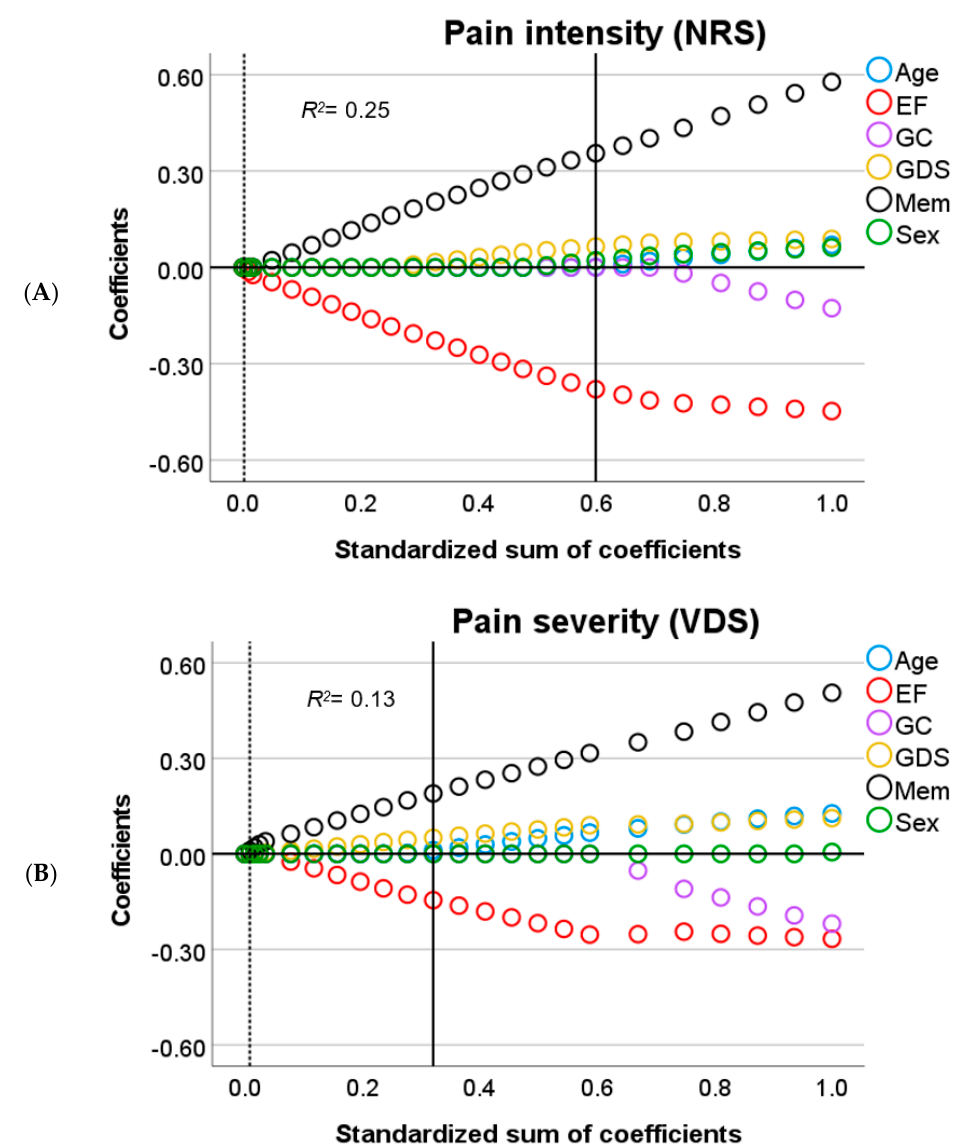
Figure 2. Output charts Lasso regression (Model 1) . Input predictors are displayed in alphabetical order but were introduced as follows: sex, age, Geriatric Depression Scale score (GDS), executive function (EF), global cognition (GC), and memory (Mem). Identified predictors and the respective dependent variables are: ( A ) sex, age, GDS, EF, and Mem as predictors of pain intensity by NRS; ( B ) age, GDS, EF, and Mem as predictors of pain severity by VDS. Lasso coefficients (colored rings) represent positively and negatively related predictors above and below zero, respectively (y–axis). Vertical lines intersect the coefficients ( ≠ 0) from the most parsimonious predictors (dotted line) and the optimal predictors (solid line) as computed in the different models (these lines might coincide). In each subfigure, the values of the x–axis represent the relative influence of all the parameters over the dependent variable before shrinkage (standardized sum of coefficients = 1.0 minus shrinkage = 0, which is equal to 1.0 on the right side). At each stage of shrinkage (increasing from right to left in the x–axis), a higher penalty is added until the standardized sum of coefficients is at its lowest (i.e., 0) and shrinkage is at its highest (i.e., 1.0). The smallest prediction error is represented by the solid line tangential to the corresponding shrinkage stage. The predictors with still meaningful associations ( ≠ 0) at such a stage are considered optimal predictors with Lasso coefficients marked in the y–axis. Regularization-R 2 is displayed on the top-left corner of each of the plots. Additional abbreviations: NRS= numerical rating scale, VDS = verbal descriptor scale.